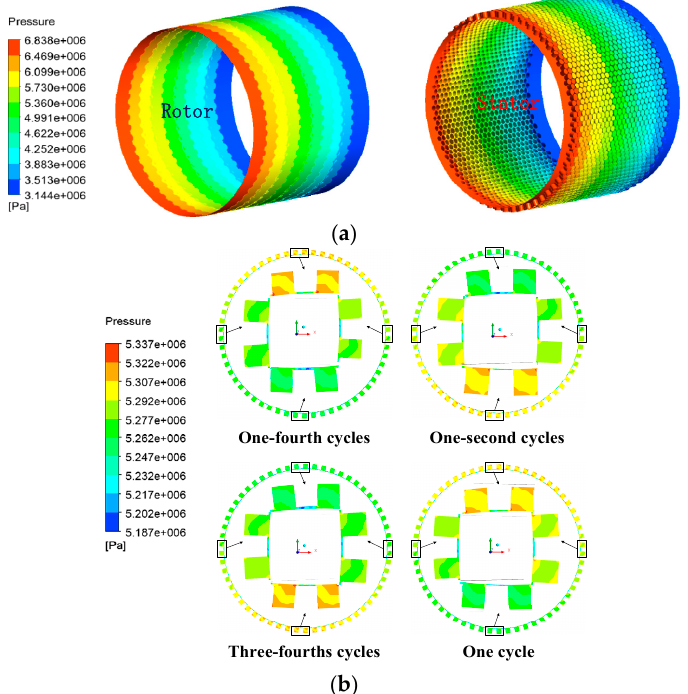
Figure 5. Two-dimensional streamlines on the midplane of the seal.